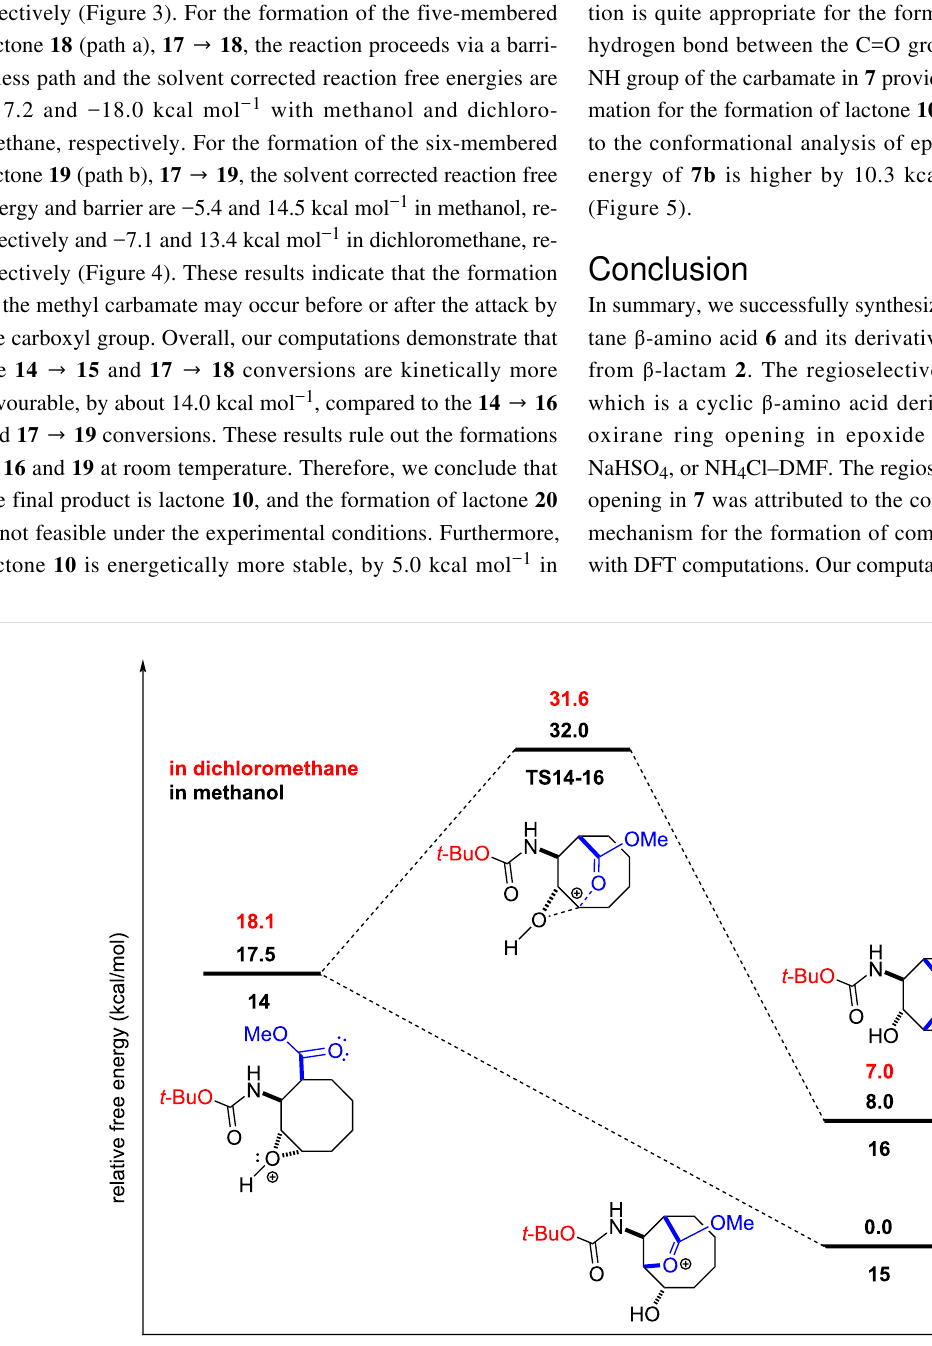
path and the solvent corrected reaction free energies are −